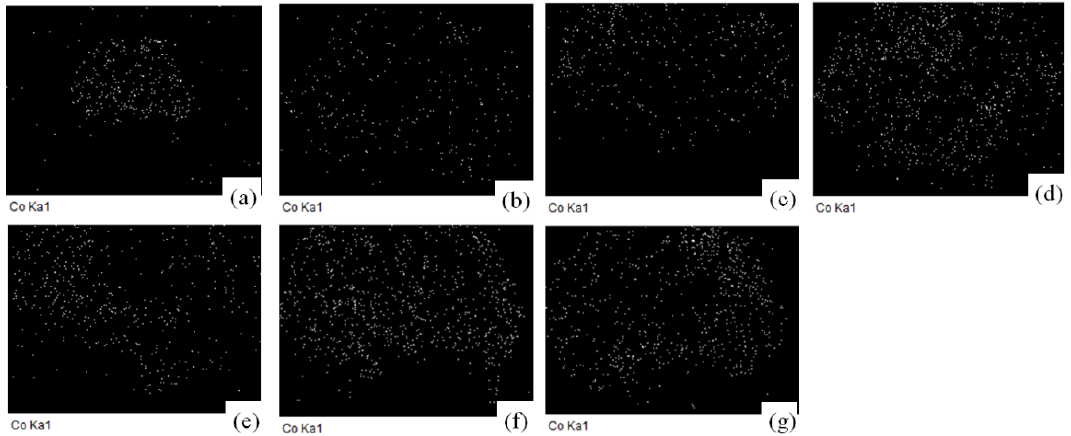
Figure 9. SEM images of the Co 2+ /Al 2 O 3 catalyst at various concentrations. ( a ) Original γ-Al 2 O 3 ; ( b ) 10 wt% Co 2+ /Al 2 O 3 ; ( c ) 20 wt% Co 2+ /Al 2 O 3 ; ( d ) 30 wt% Co 2+ /Al 2 O 3 ; ( e ) 35 wt% Co 2+ /Al 2 O 3 ; ( f ) 40 wt% Co 2+ /Al 2 O 3 ; ( g ) 45 wt% Co 2+ /Al 2 O 3 ; ( h ) 50 wt% Co 2+ /Al 2 O 3 .